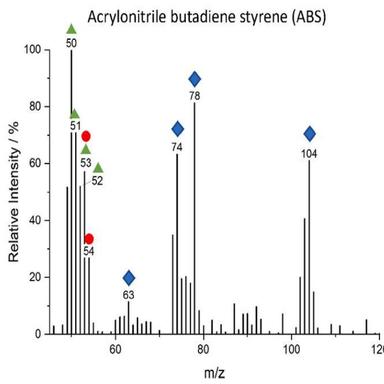
LA-EI-MS spectrum of ABS showing the characteristic m/z fragments of the different monomers in the spectrum; m/z values of 50–53 are characteristic for acrylonitrile ( ), m/z of 53 and 54 show butadiene ( ) and m/z of 63, 74, 78 and 104 originate from styrene ( ).